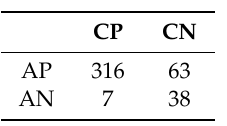
Table 6. Detection rate of dynamic hazardous objects in the front direction (daylight).